Question: Author a descriptive caption for the visualization shown.
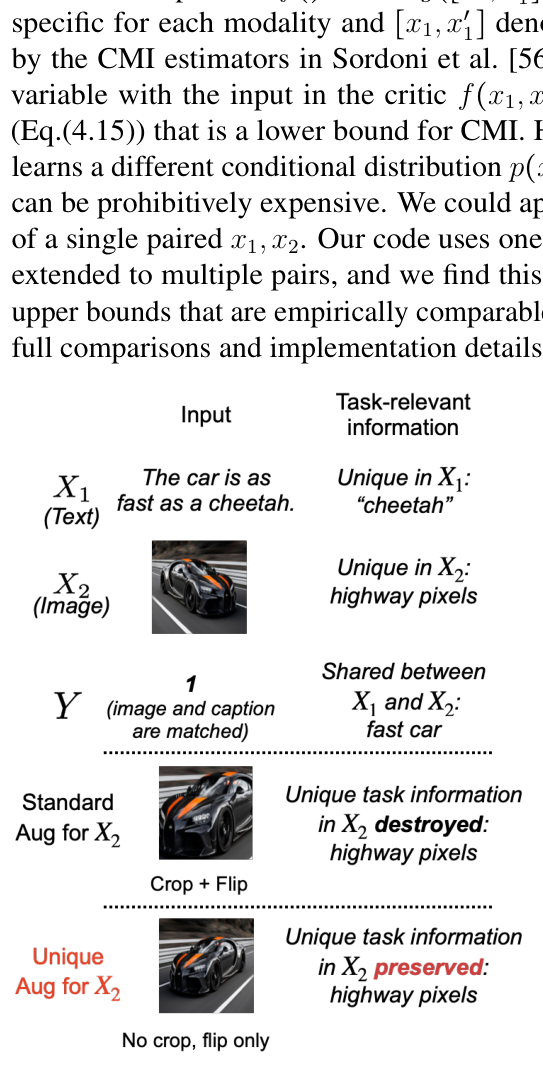
Answer: 1: Left: We define S = I(X1;X2;Y ) as task-relevant shared information and U1 = I(X1;Y ∣X2), U2 = I(X2;Y ∣X1) as task-relevant unique information. Right: On controllable datasets with varying ratios of S, U1, and U2, standard CL captures S but struggles when there is more U1 and U2. Our FACTORCL approach maintains best performance, whereas SimCLR [103] and SupCon [300] see performance drops as unique information increases, and Cross+Self [258, 278, 337, 710] recovers in fully unique settings but suffers at other ratios.